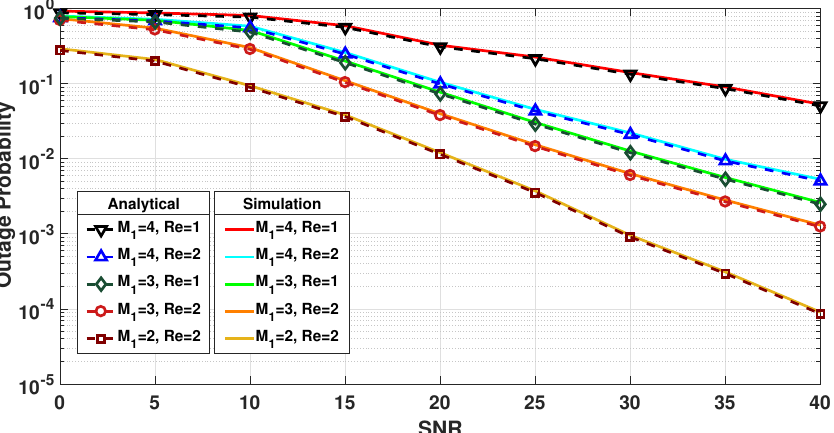
Figure 3. Impact of M 1 and R e on outage probability of proposed Q-CNOMA system.